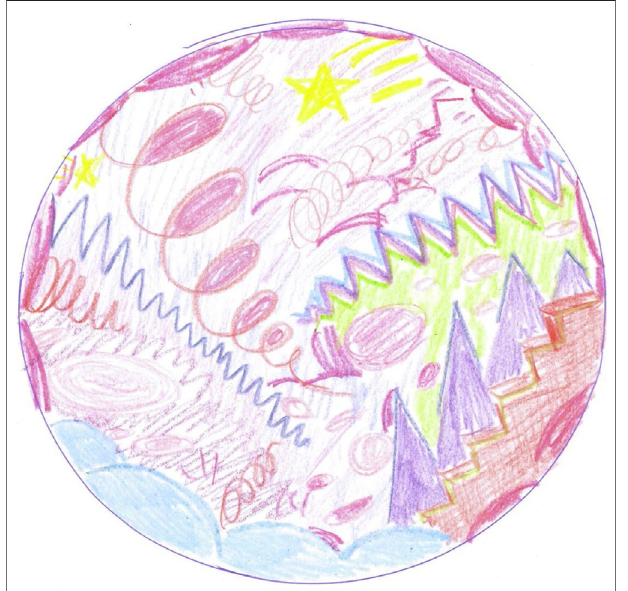
FIGURE 7 | The feeling of joy and love was the energy in the universe, completely intense and multiplied by 100. It was like taking those two emotions and concentrating them, to have them in their purest form without any worries or other troubles that can come with everyday reality. Everything else ceased to matter while those two emotions were so pure — they made everything incredibly beautiful. When I was soaring through the soundwaves with this energy, I could see all the people close to me in my life appear. My partner, my sister and her boyfriend and their new-born son, my mother, my amazing friends. I felt immensely privileged to be part of this universe/community, to be able to feel those feelings in such a pure form, to have suchdeep emotions inmy body — and Iwasoverwhelmedwithgratitude for this world. That everything simply is. And with that I was overtaken by a desire to protect it all, to show the world how beautiful it is and to take care of it. Report 3, female, CME, MEQ total